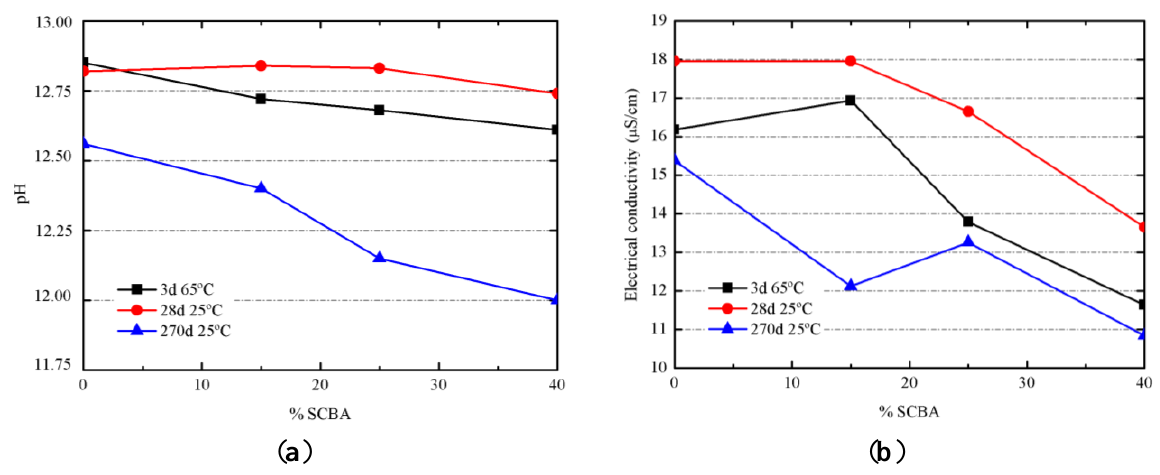
Figure 11. Evolution of the properties of alkali-activated pastes: ( a ) pH values; ( b ) electrical conductivity